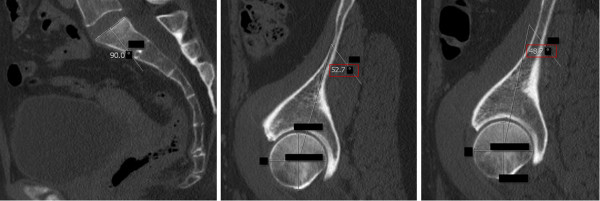
Pelvic Incidence (PI): The PI was determined on sagittal CT planes of the pelvis. A line was drawn along the axis of the superior end plate of S1 (left image). Then, originating at the center of this axis, an orthogonal line was drawn (left image). Secondly, the middle of the femoral head was determined by the intersecting point of a vertical and horizontal line within the femoral head (middle and right image). Finally, a line was drawn from the middle of the each femoral head to the center of the superior end plate axis and the angle was measured in regard to the orthogonal line originating at this point (middle and right image). The red box indicates the PI. The blacked out numbers were disregarded because they were created automatically by our software and contained irrelevant information. In order to acquire the superposition of the two femoral heads, left and right, the PI was measured for both sides and the mean was stated.